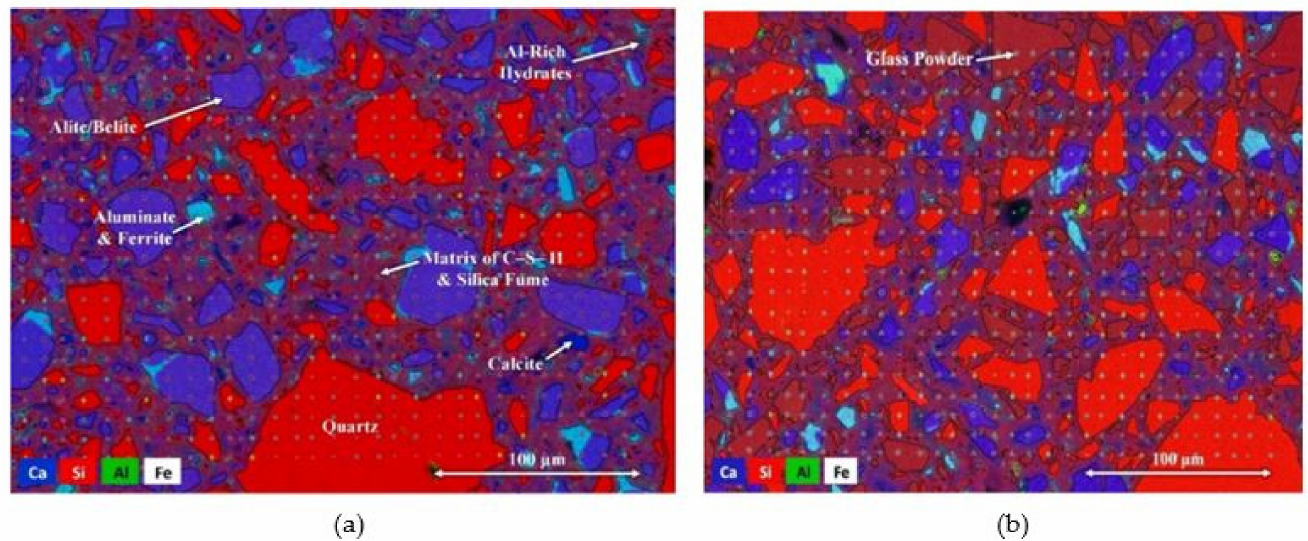
Figure 9. Chemical mapping of the surface in an ultra-high performance concrete (specimen showing the different anhydrous and hydrous phases) ( a ) without WG; ( b ) with 30% WG (12 µ m particles) replacing cement